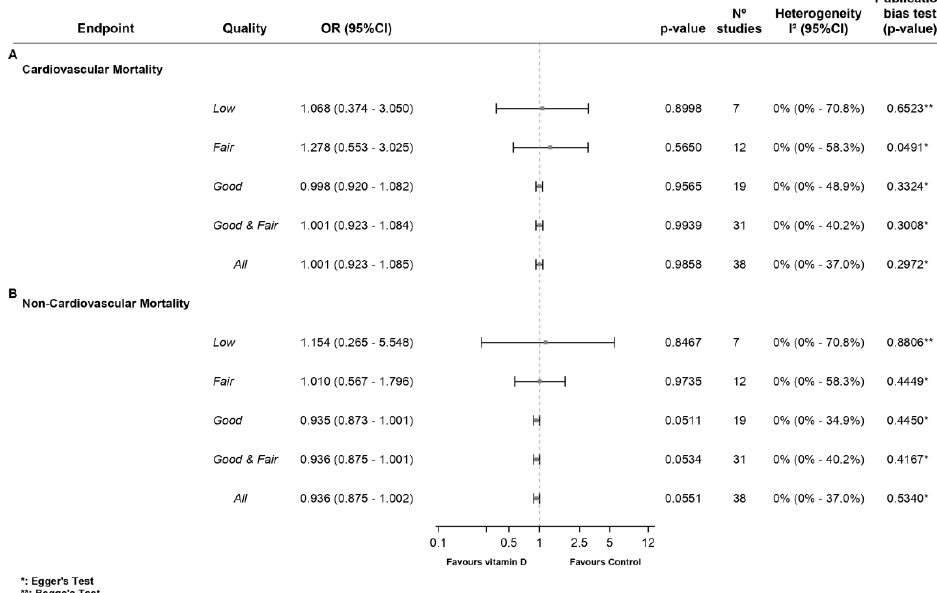
Figure 3. Effect of vitamin D supplementation on cardiovascular and non-cardiovascular mortality. ( A ) Forest plot of cardiovascular mortality. ( B ) Forest plot of non-cardiovascular mortality.